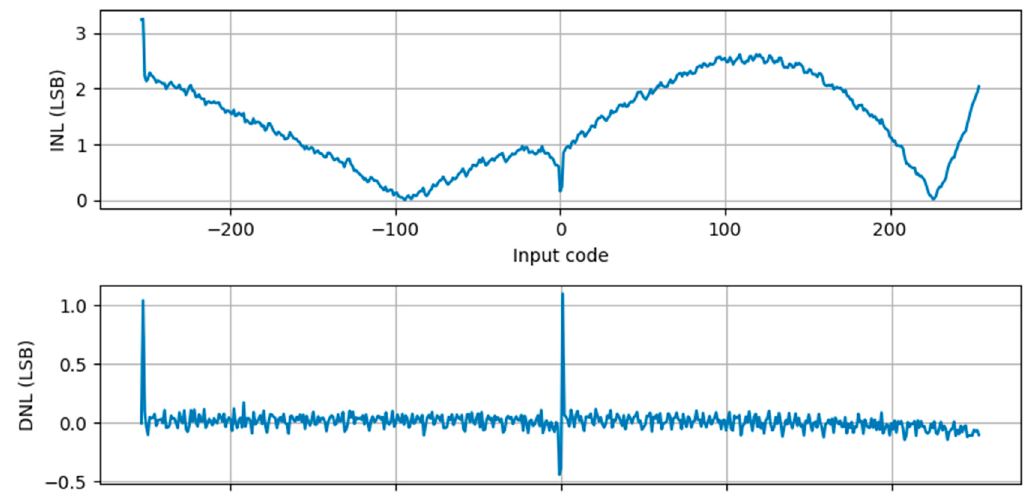
Figure 10. Static linearity of the stimulation system: the measured quantity is the current over a 10 k Ω load. Top curve: Integral Nonlinearity (INL). Bottom curve: Differential Nonlinearity (DNL). INL and DNL are expressed in LSB = 1 mA/256 ≈ 3.9 µA.